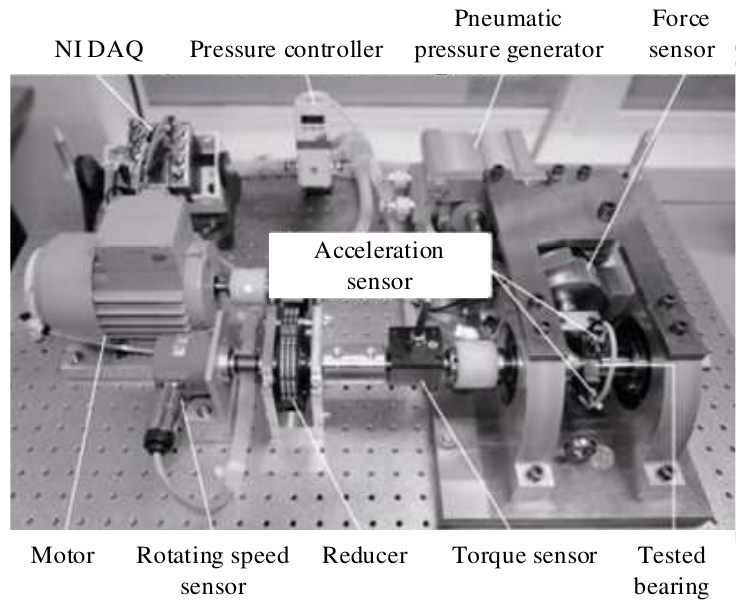
Figure 14. PRONOSTIA test bench. Table 2. Description of the PHM2012 dataset.